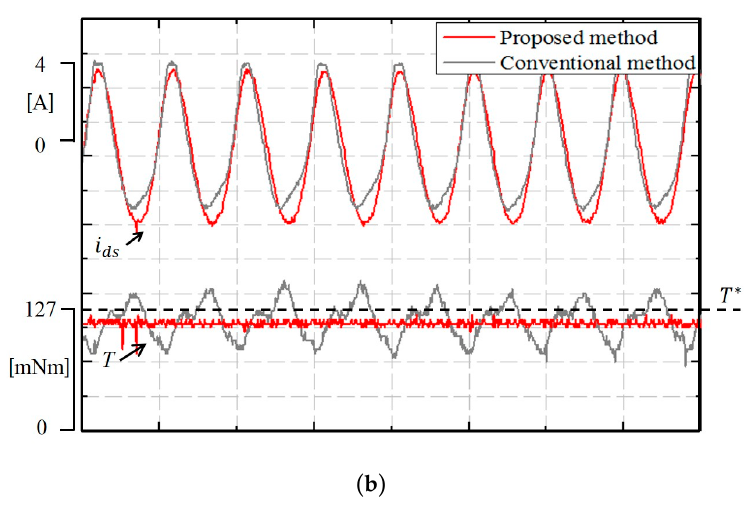
Figure 11. Comparison of torque control characteristics between current-voltage model and voltage model ( a ) permanent magnet temperature = 25 °C ( b ) permanent magnet temperature = 100 °C (Operating condition: ω r = 65 rad/s, Torque command: 127 mNm).